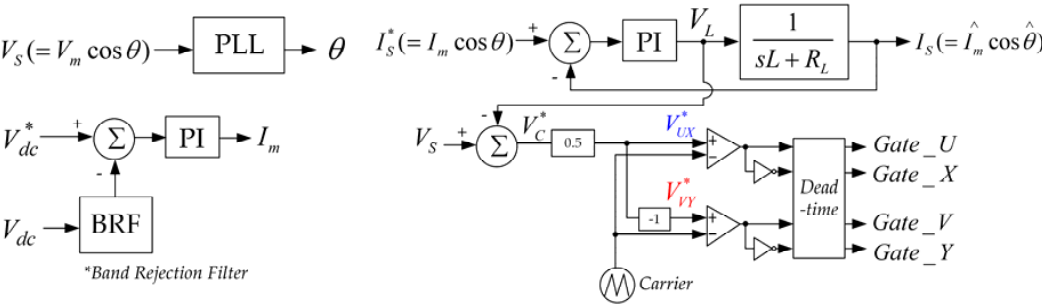
Figure 2. Control block diagram of conventional PWM converter using instantaneous current controller including phase-locked loop (PLL), voltage controller, and PWM generator.